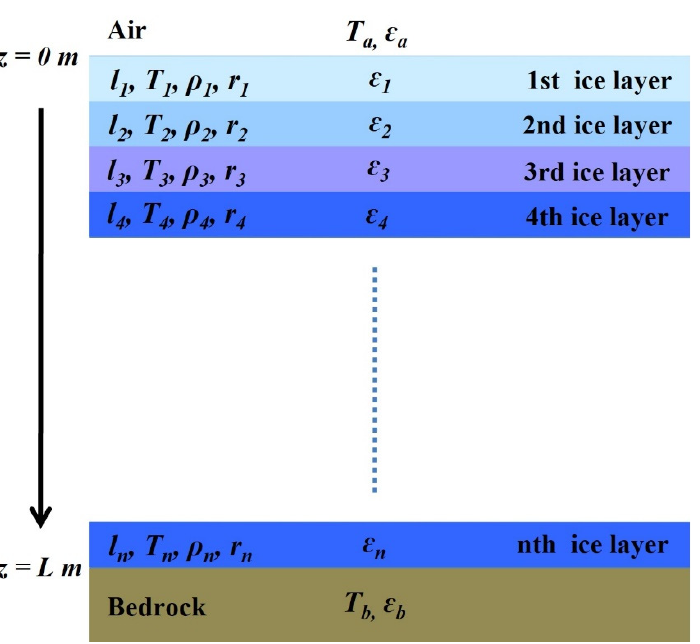
Figure 1. Vertical structure of layered polar firn. Each layer is defined by its length ( l ), temperature ( T ), density ( ρ ), and snow grain radius ( r ). These parameters lead to unique complex permittivity ( ε ) values for each layer.